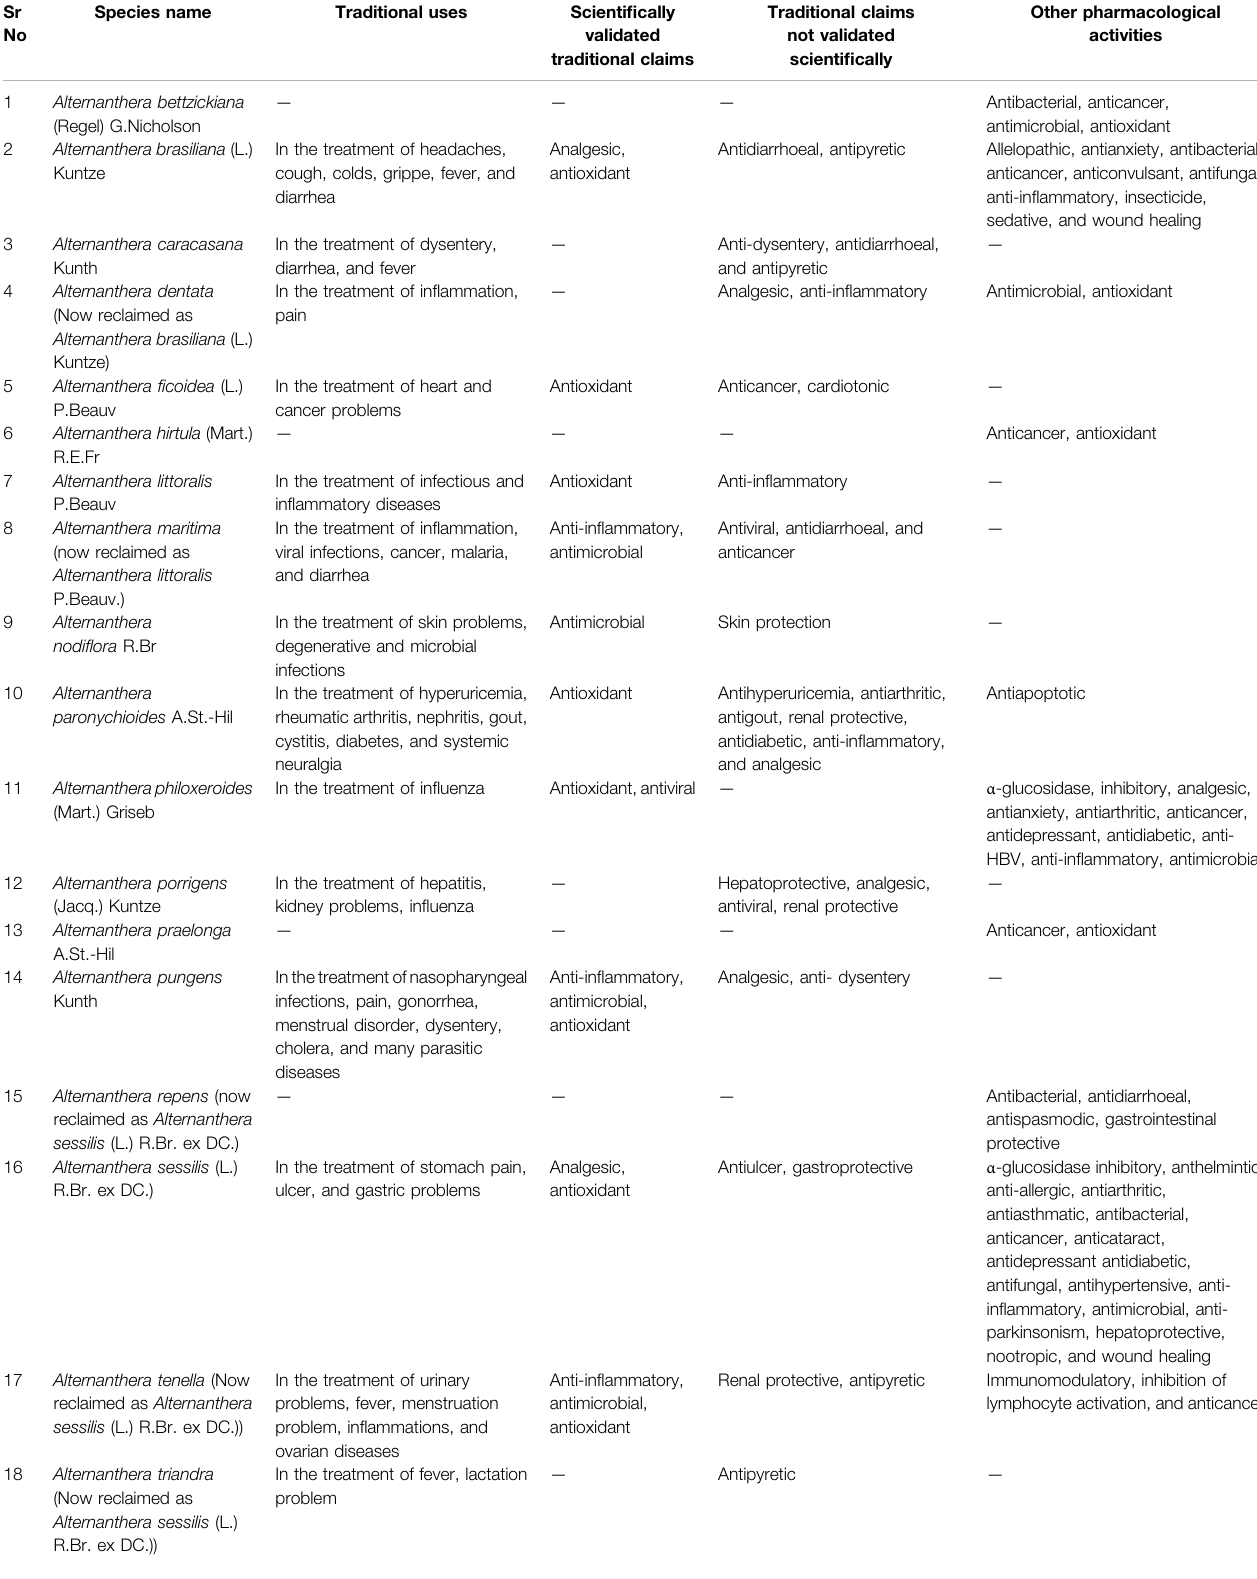
TABLE 3 | Relationship between reported scienti fi c pharmacological activities of Alternanthera species and their traditional